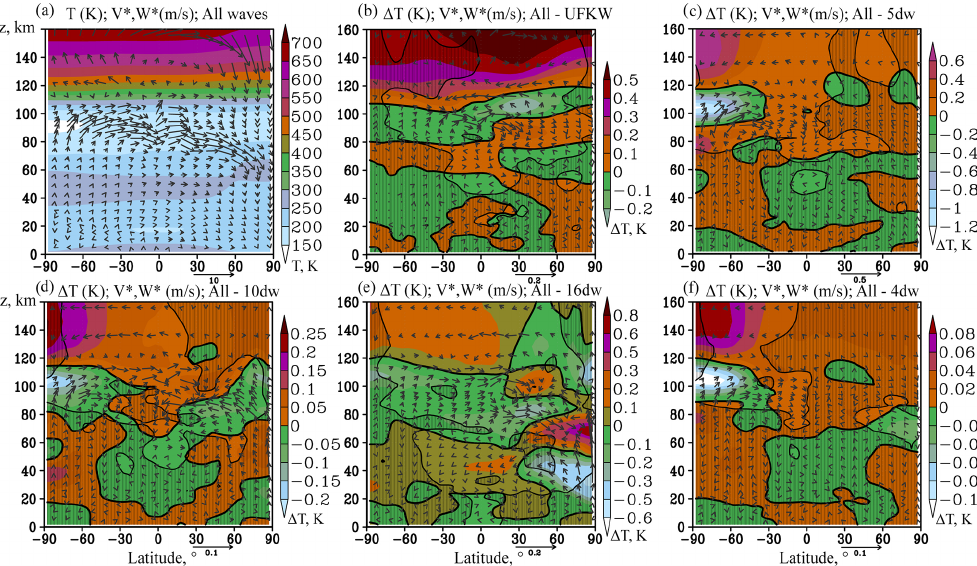
Figure 2. (a) RMC components (arrows, ms − 1 , vertical component multiplied by 200) and mean zonal temperature components (colours, K) for January–February with all PW sources turned on; (b–f) increments in RMC and temperature due to switching off sources of PWs: UFKW, 5, 10, 16 and 4d waves, respectively. Shaded areas show insignificant temperature and/or RMC increments at 95%.